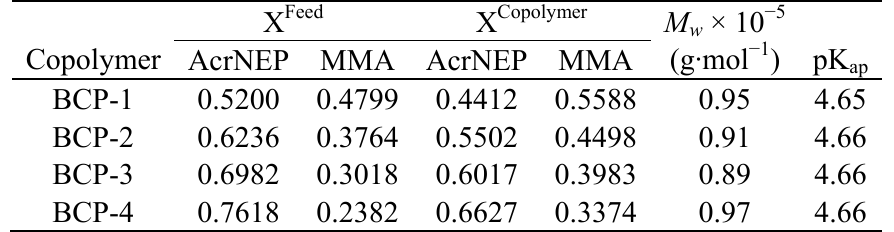
Table 1. Feed compositions in the synthesis and characterization of copolymers.